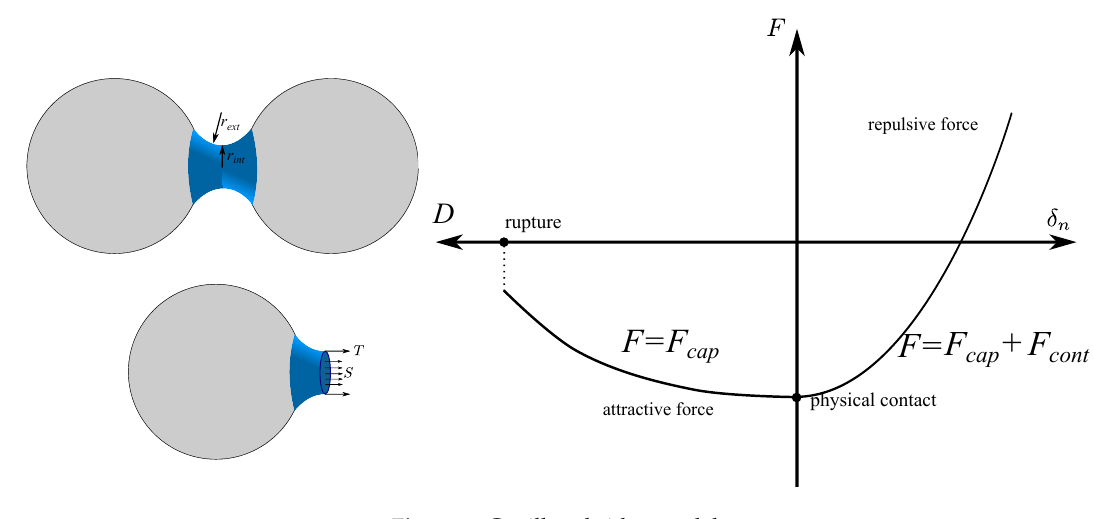
Figure 2. Capillary bridge